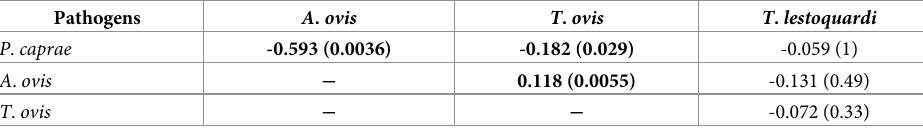
Table 6. Fisher’s exact test for the coinfection of two pathogens.